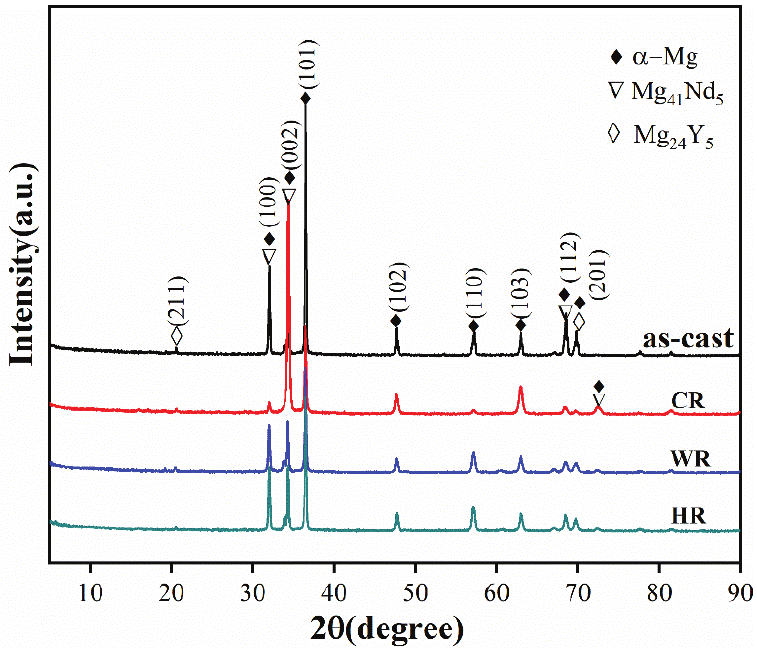
Figure 2. XRD patterns of WE43 in as-cast, cold-rolled, warm-rolled, and hot-rolled condition. Figure 3 shows the SEM images of the microstructures of as-cast, cold-rolled, warm- rolled, and hot-rolled WE43. It can be seen that the as-cast alloy was mainly composed of equiaxed α -Mg phases with the eutectic Mg 24 Y 5 phases at the grain boundaries, and the average grain size was about 70 µ m. After cold rolling, the grains of the alloy were slightly elongated along the rolling direction and apparently refined. Close observation revealed that the eutectic phases at the grain boundaries disappeared, and a small amount of regular fine Gd-rich phases still remained at the grain boundaries. For the warm-rolled sample, large amounts of the fine Mg 41 Nd 5 phase precipitated inside grains. It can be seen from the morphology of hot-rolled samples that the Mg 41 Nd 5 phase was basically broken and dissolved in the matrix, and a small amount was precipitated on the grain boundary. To clearly illustrate the effects of the rolling temperature on the microstructure of the alloy, EBSD analysis was conducted on the samples after rolling at different temperatures. Figure 4 shows the EBSD maps showing the grain structures of as-cast, cold-rolled, warm- rolled, and hot-rolled WE43. It can be seen that the grain size of the as-cast sample was greatly reduced after rolling treatment. The average grain size of the cold-rolled sample was 7.75 µ m. With the rolling temperature increasing, the grain size of the alloy was slightly increased. The average grain sizes of the warm-rolled and hot-rolled samples were 8.88 µ m and 9.64 µ m,